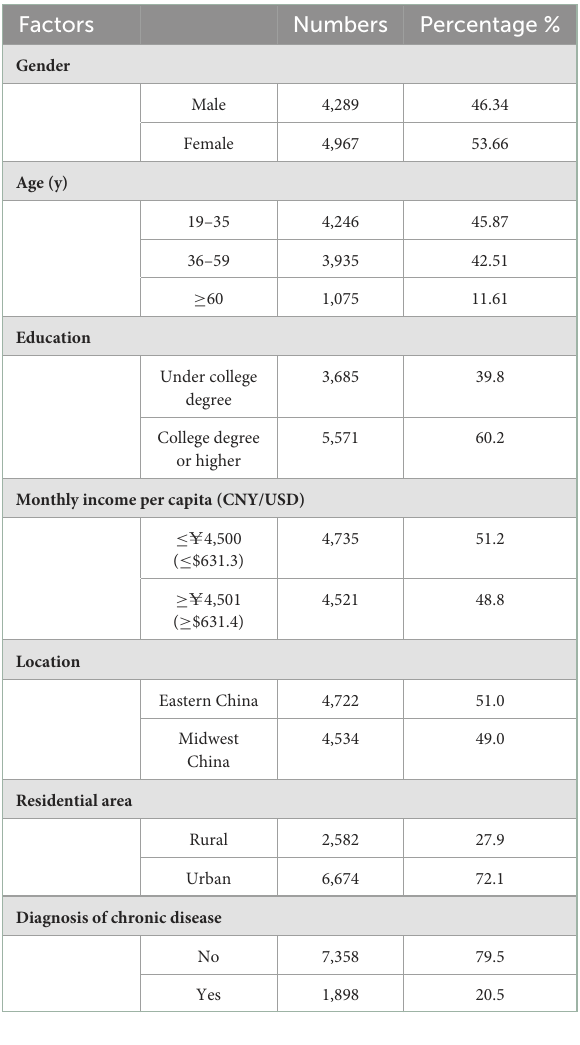
TABLE 1 Personal characteristics of the